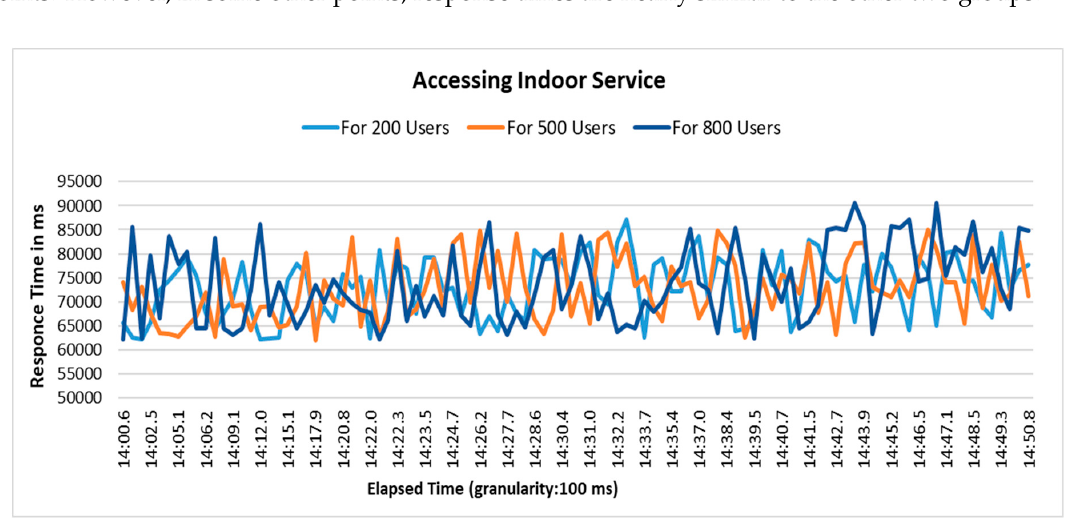
Figure 18. Round Trip Time for accessing indoor service.